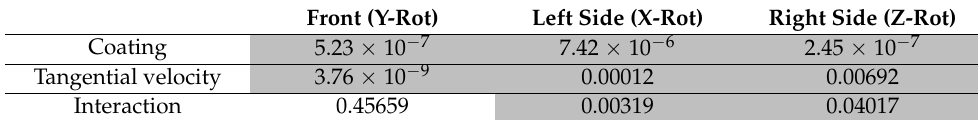
Table 4. Two-way ANOVA results ( p -values) for the HIC. p -values < 0.05 portrayed as shaded cells. Front (Y-Rot) Left Side (X-Rot) Right Side (Z-Rot)